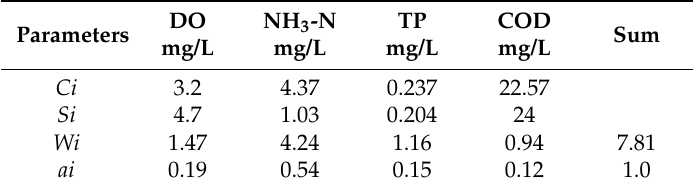
Table 7. Weight coefficient of water quality evaluation of Section F before treatment.